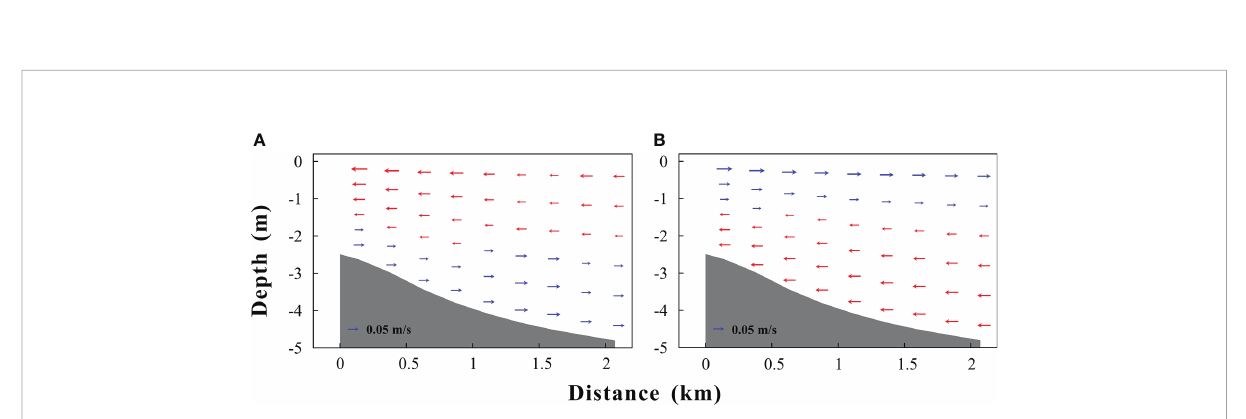
FIGURE 9 25h-averaged vertical distribution of residual currents at P2 pro fi le with red arrows indicated onshore and blue arrows indicated offshore in Exp.10 (A) , Exp.11 (B) ,